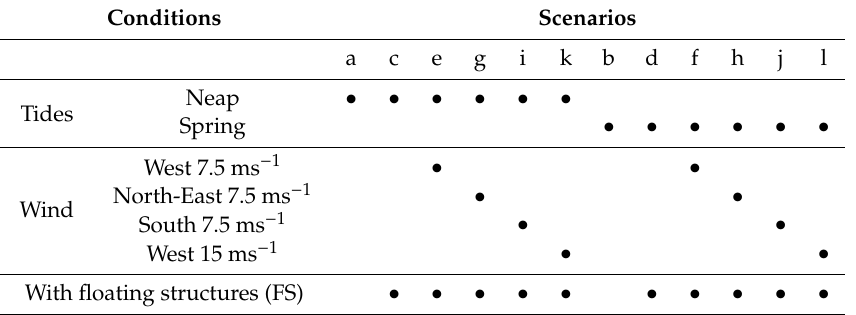
Table 1. Summary of the scenarios tested and analysed in the